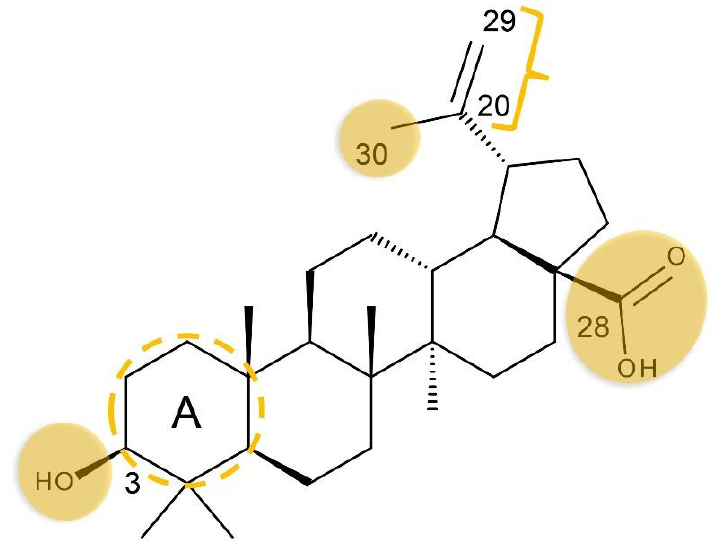
Figure 1. The main structural sites of betulinic acid susceptible to chemical modulation.